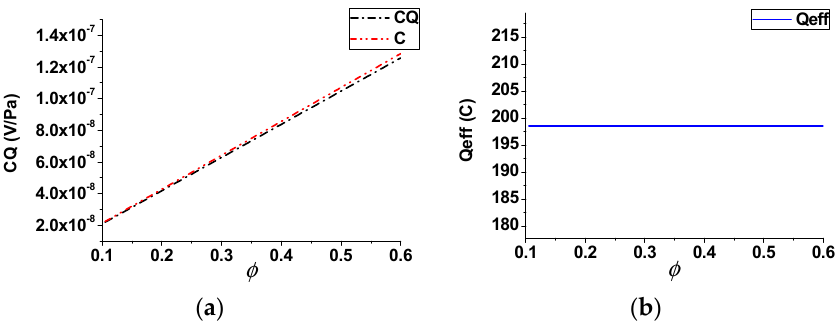
Figure 3. Effect of the porosity (steady case): ( a ) streaming potential coupling coefficient; ( b ) effective net residual charge density.